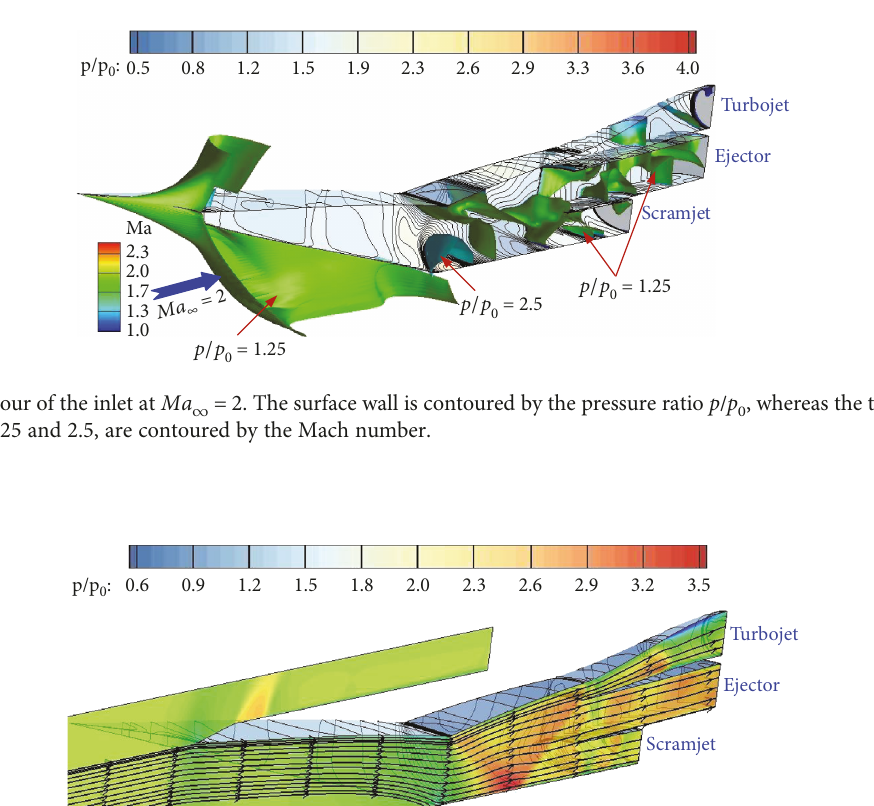
Figure 9: Flow contour of the inlet at Ma path.